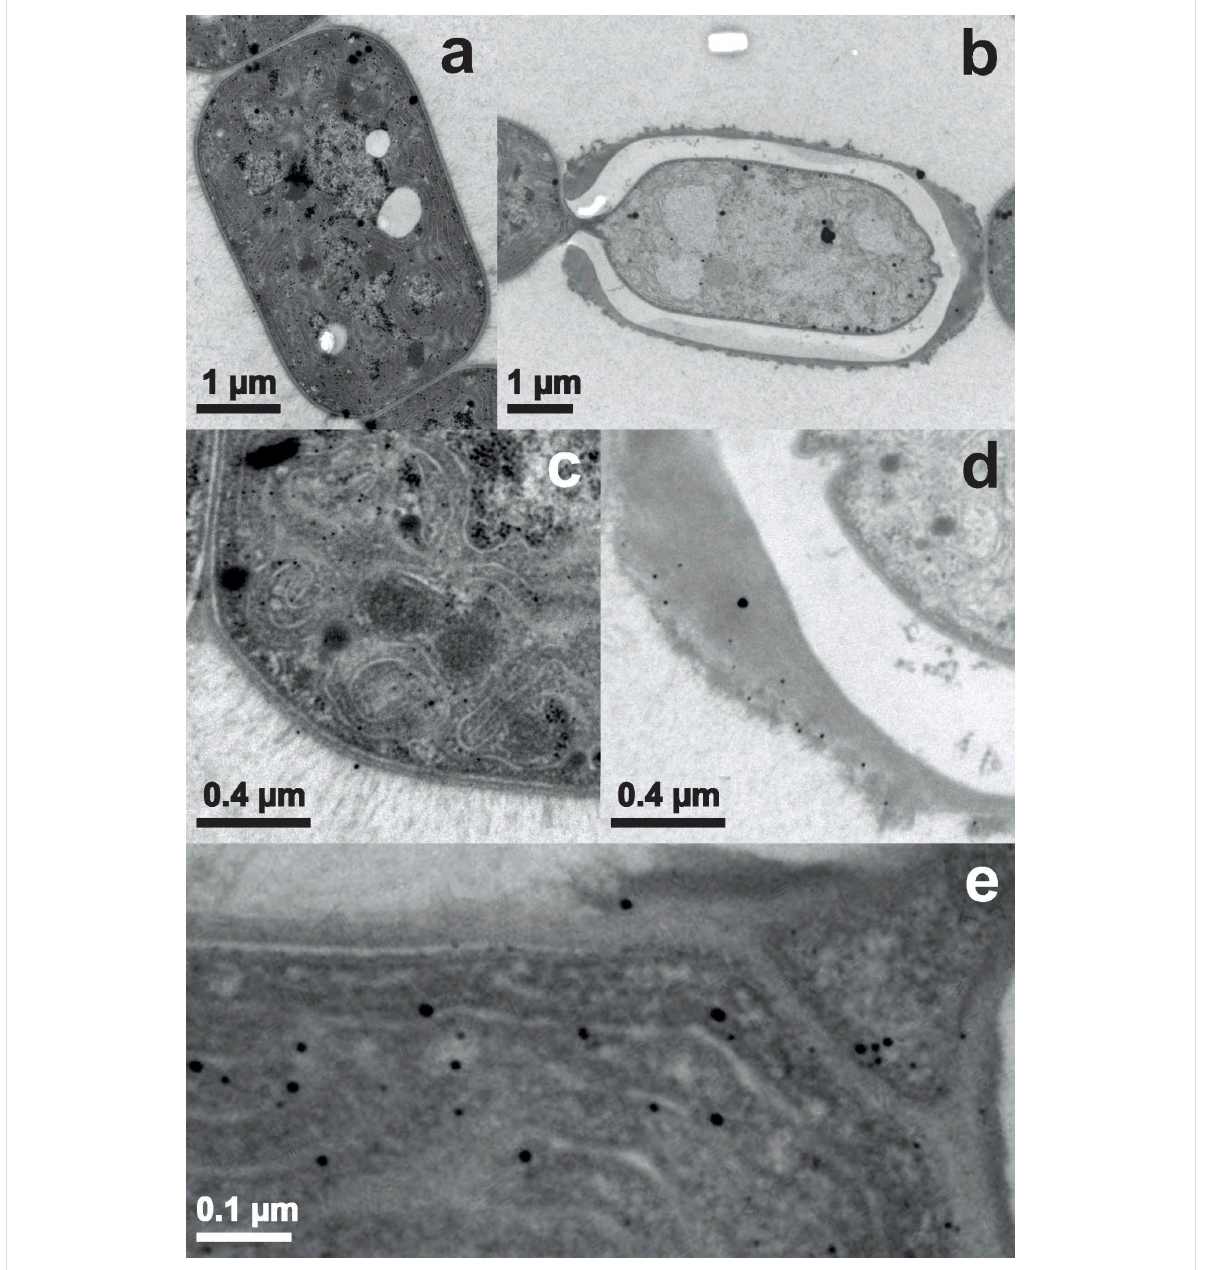
Figure 4: TEM images of Anabaena cylindrica incubated with an overall concentration of 0.8 mM Au 3+ for 9.25 hours. Vegetative cells are displayed in panel (a) and (c), heterocysts in (b), (d) and (e).